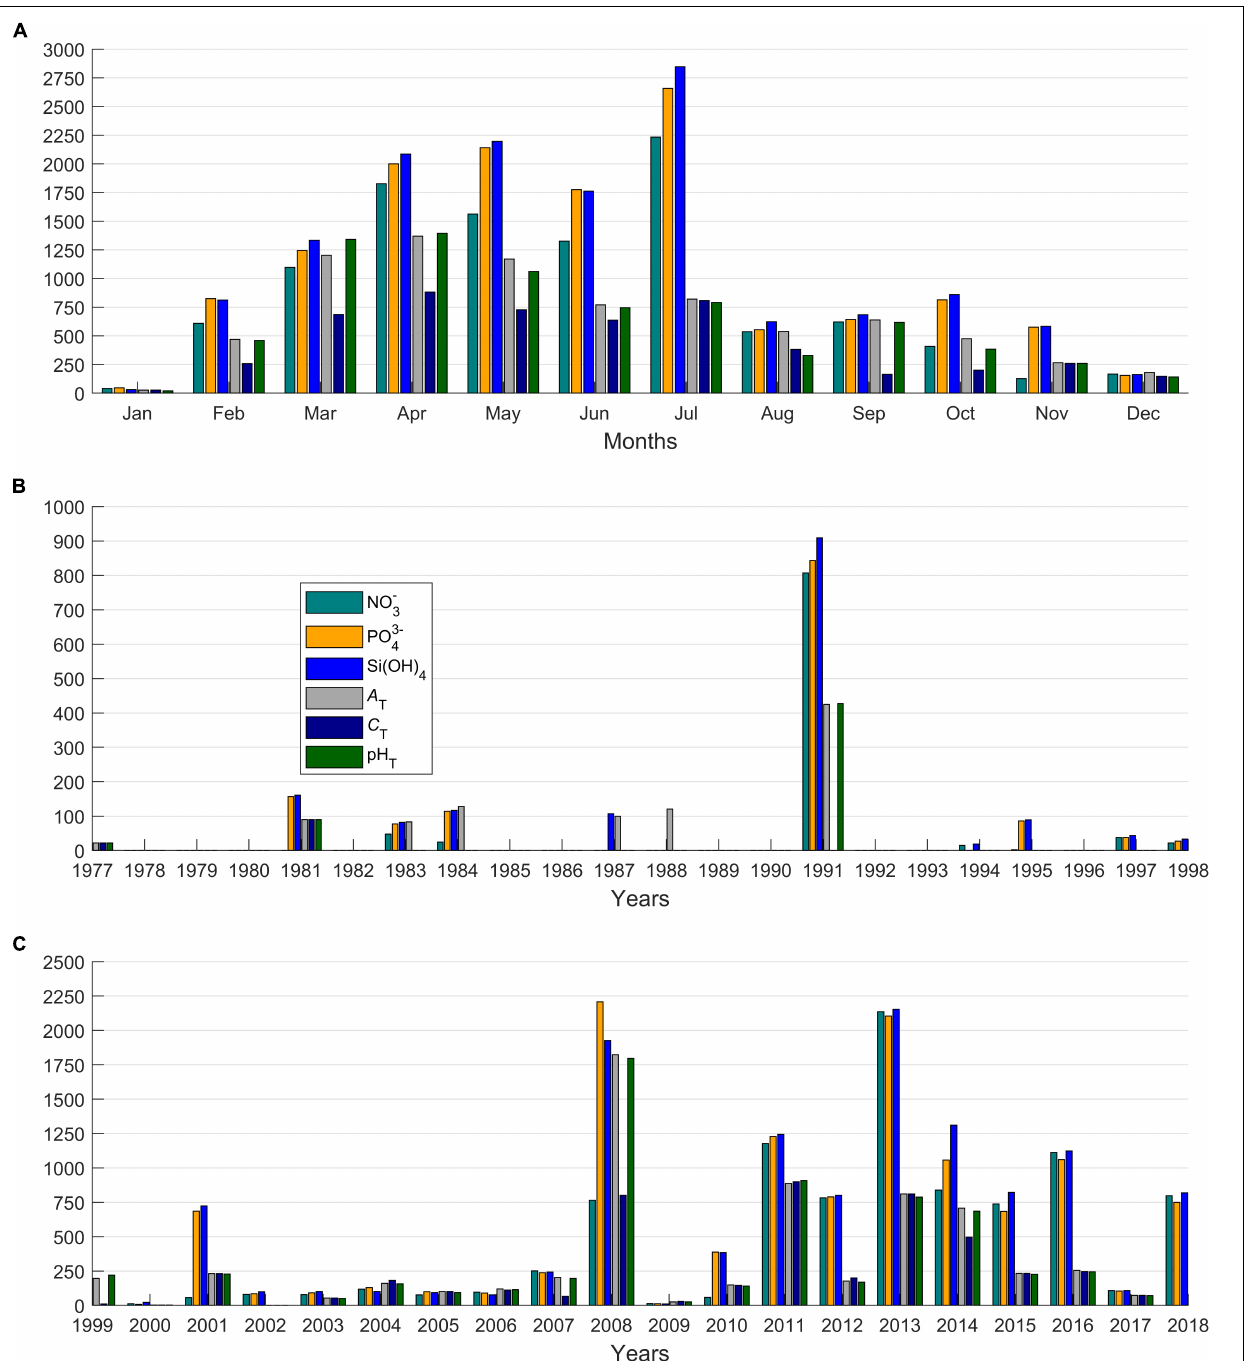
FIGURE 2 | Distribution of sample numbers (A) per month and (B,C) per year provided by the scientific cruises, after quality control. Note the difference in the y-axis for the early distributions.